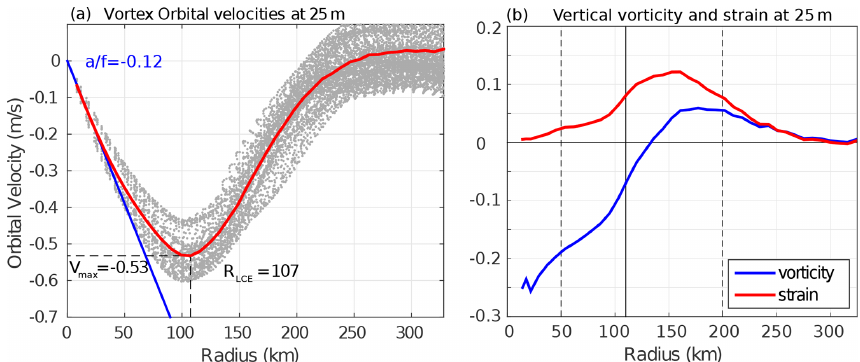
Figure 4. (a) Orbital velocities at 25m depth as a function of the radius of each detected LCE (light gray dots). The red line is the LCE orbital velocity profile of the annually averaged composite. (b) Vertical vorticity and strain computed from the averaged orbital velocity profile assuming no radial velocity in cylindrical coordinates as ζ z = 1